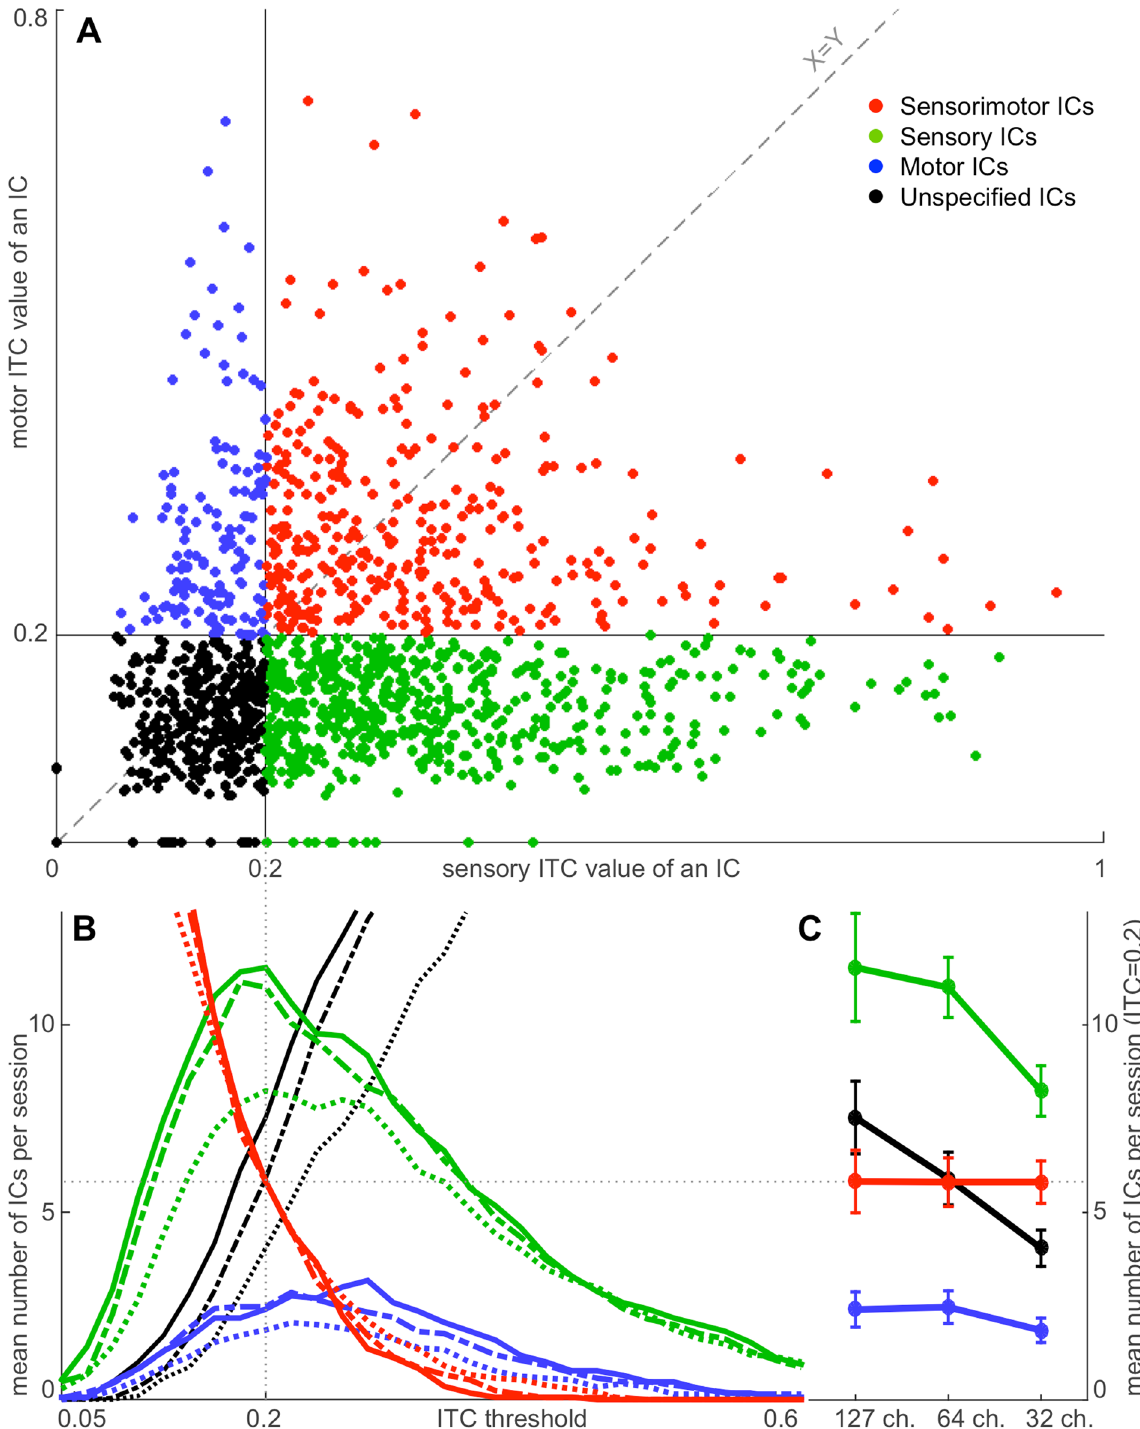
Figure 4. Distribution of ICs into the four groups: Motor, Sensory, Sensorimotor, and Unspecified. Panel (A) depicts 1412 accepted ICs in the study from 32-, 64- and 127-channel datasets. Each dot represents an IC with a Sensory ITC value as the X coordinate and a Motor ITC value as the Y coordinate. Blue dots represent Motor ICs. Green dots represent Sensory ICs. Red dots represent Sensorimotor ICs. Black dots represent Unspecified ICs. The vertical black line at X = 0.2 represents the sensory ITC threshold, and the horizontal black line at Y = 0.2 represents the motor ITC threshold to separate ICs into the four groups. The grey diagonal dashed line (X = Y) represents the ITC-threshold trajectory of the intersection of the threshold lines. The results of distribution of ICs into the four groups at different points of the trajectory are shown in Panel (B). The X-axis is derived from the X = Y dashed line in Panel (A). The Y-axis represents a mean number of ICs in a group per session at different points of the grey diagonal dashed ITC-threshold-trajectory line (X = Y) in Panel (A). The grey dotted line at X = 0.2 indicates the selected ITC threshold for Sensory and Motor ITC values in Panel